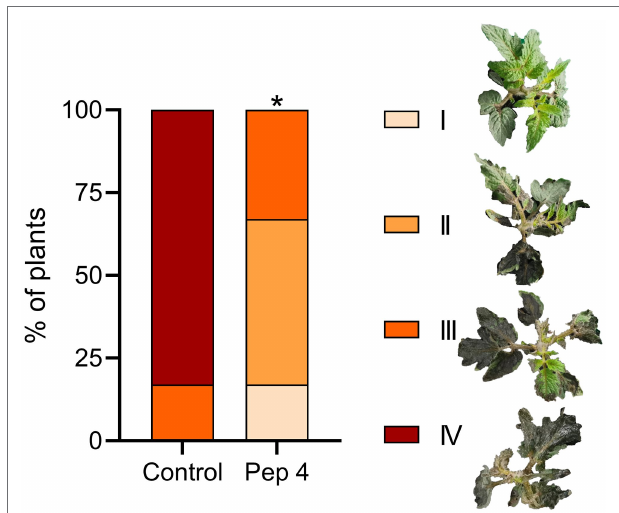
FIGURE 4 | Pep 4 protects tomato plants from Botrytis cinerea infection. Two-week-old Solanum lycopersicum cv. Micro-Tom plants were sprayed on the upper (adaxial) leaf surfaces with 50 μ M peptide solution in 0.01% v/v of Silwet L-77 AG, and spray inoculated on the same surface 48 h later with a conidial suspension of B. cinerea . Disease severity was evaluated by assigning plants to different classes, ranging from I (no or point limited